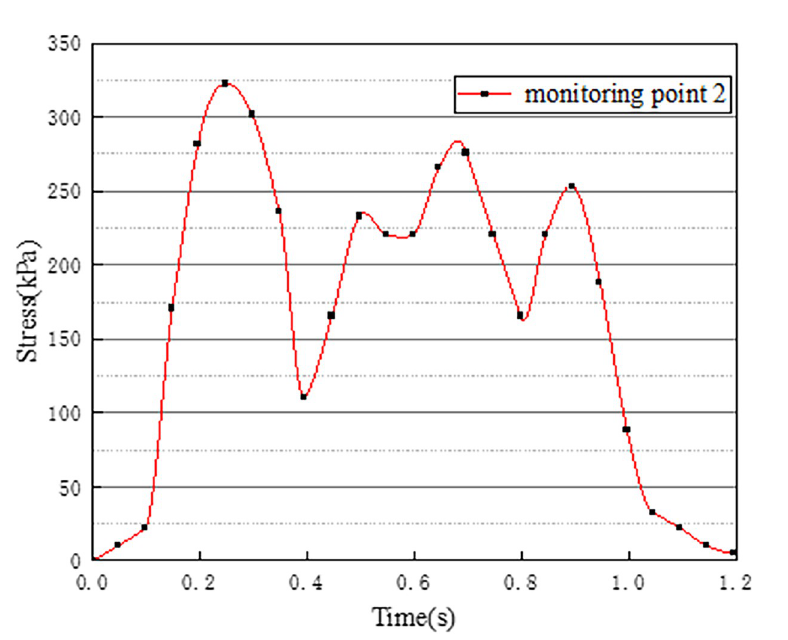
Fig 12. Stress time history curve of monitoring point 2.